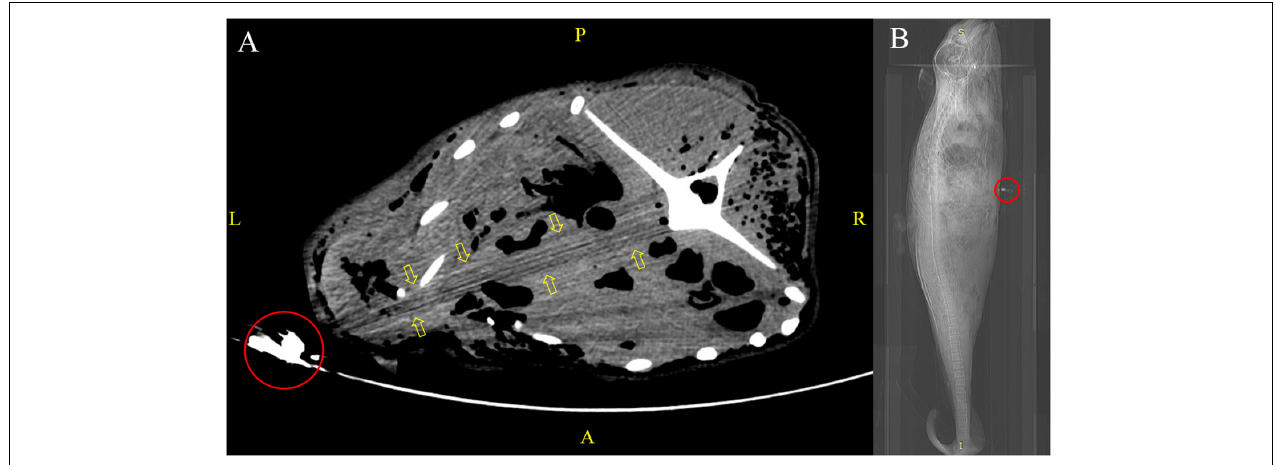
FIGURE 3 | Virtopsy of an adult finless porpoise kept in a human cadaver pouch. (A) Metallic zipper (red circle) of the cadaver bag in the PMCT scan field led to streaking artifacts (yellow arrows) that mimicked an abnormality in adjacent structures. (B) CT scout view of the same case with metallic zipper (red circle) positioned at the thorax region.